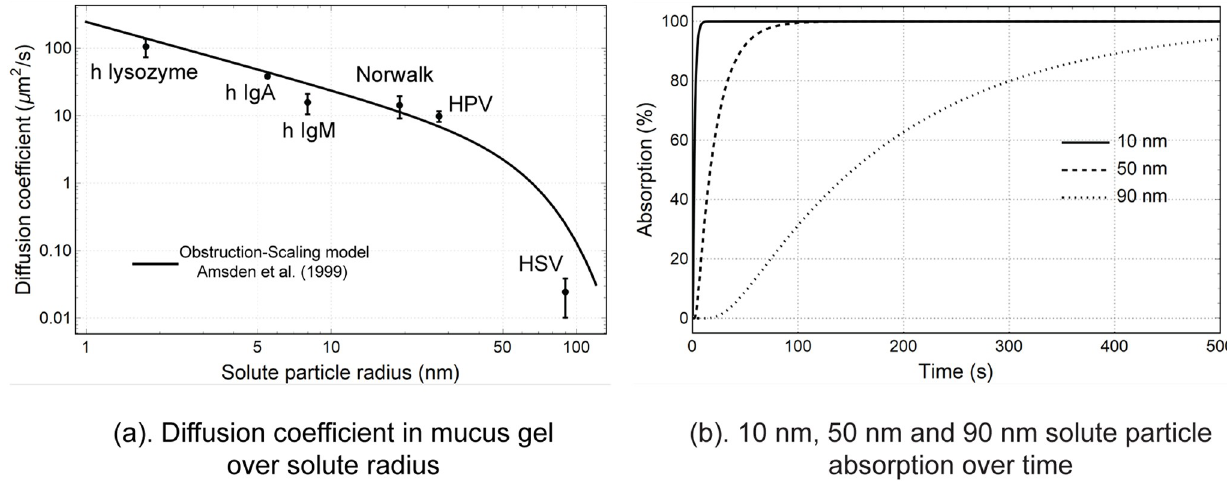
Fig 11. Properties for dissolved drug particle diffusion through mucus gel layer. (a) Solutes’ diffusion coefficient were calculated using Obstruction- Scaling model and plotted with typical macromolecular measured in the study of Olmsted et al. [32]. h represents human proteins, (b) Absorption functions over time predicted by Eq (11) were plotted for solute particles with an effective radius of 10 nm , 50 nm and 90 nm .